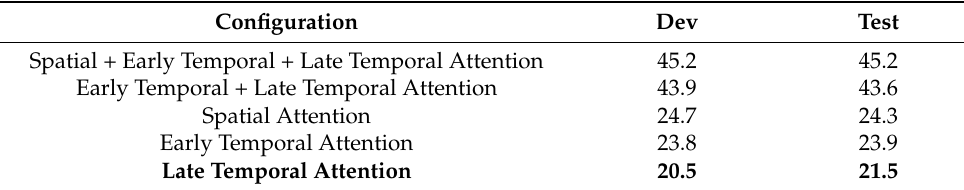
Table 2. WER Performance comparison using different attention configuration.